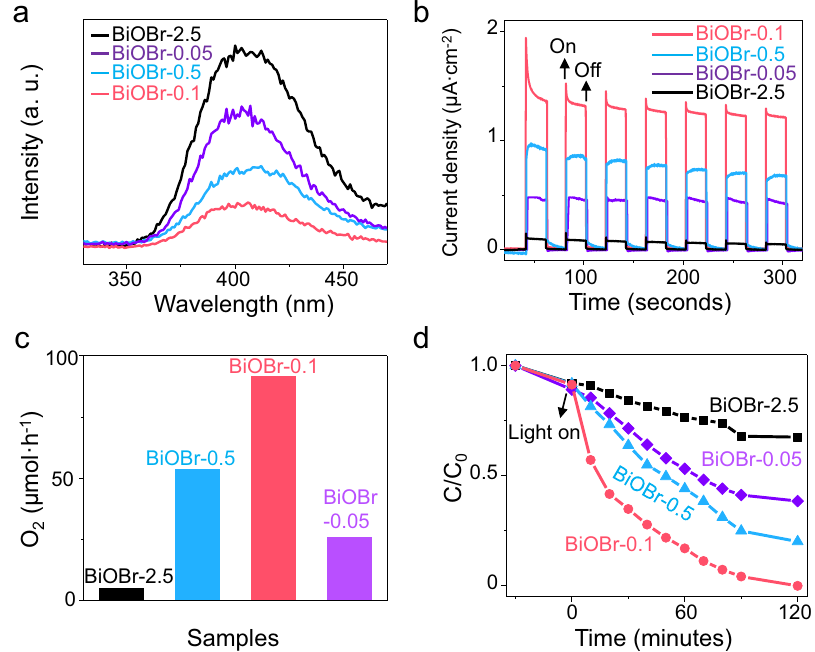
Fig. 5 The photocatalytic performance of BiOBr platelets with different lateral sizes. a The photoluminescence (PL) spectra, b chronoamperometry (CA) curve spectra, c the performance of photocatalytic oxygen evolution, and d photocatalytic reduction of Cr(VI) to Cr(III) for BiOBr-2.5, BiOBr-0.5, BiOBr-0.1, and BiOBr-0.05 platelets, respectively. Source data are provided as a Source Data fi